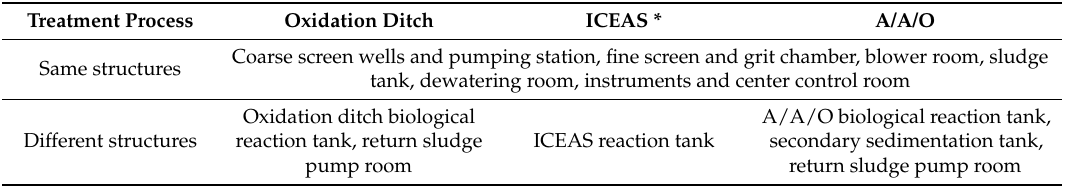
Table 3. Comparison between three types of sewage treatment process structures.